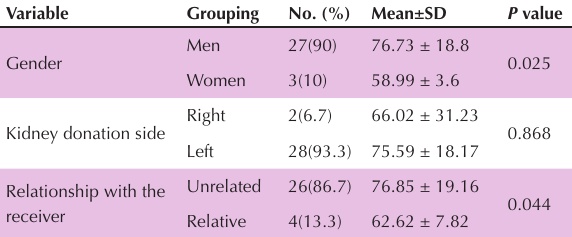
Table 3. Relationships demographic variables with GFR at the time of the study